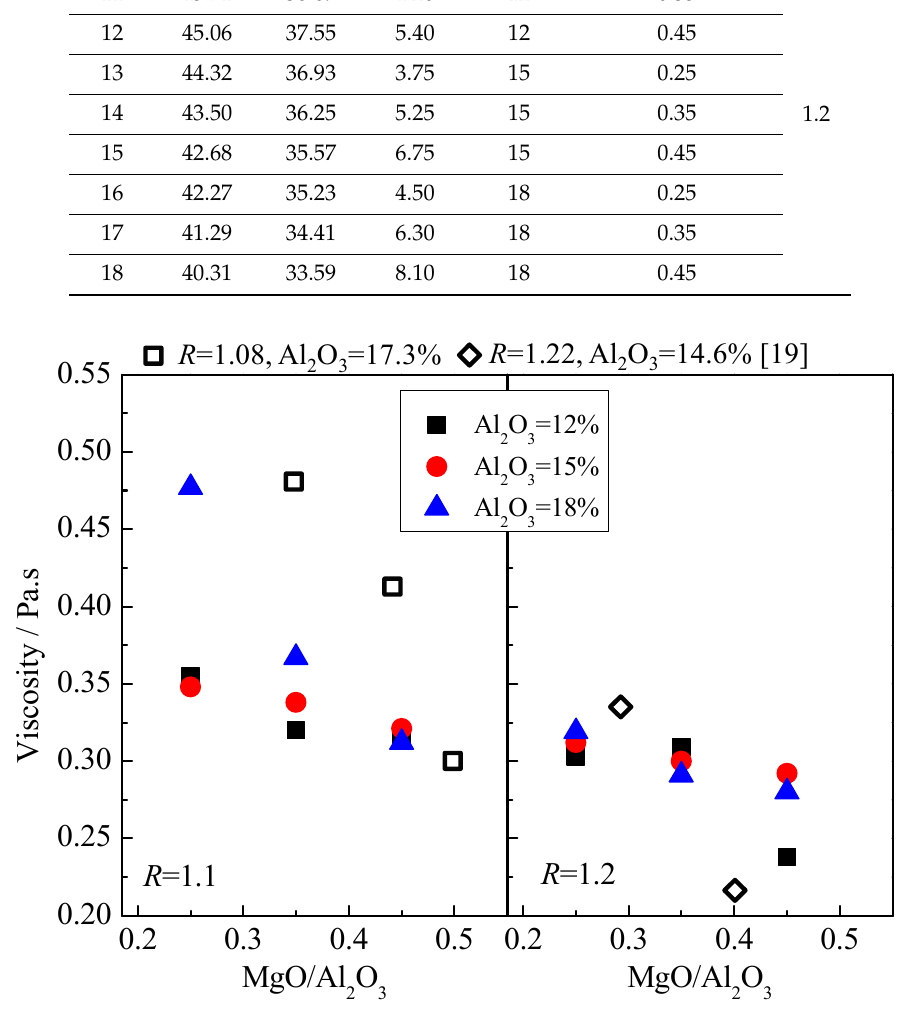
2 O 3 ratio on slag